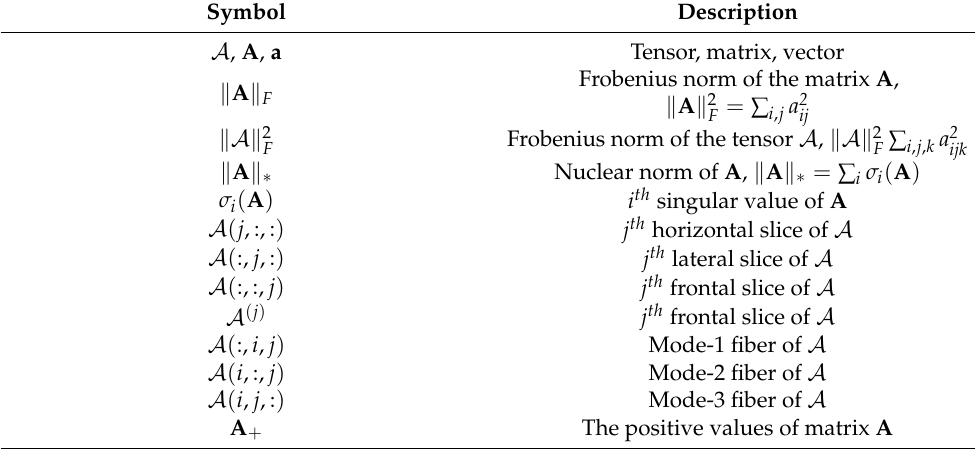
Table 1. List of